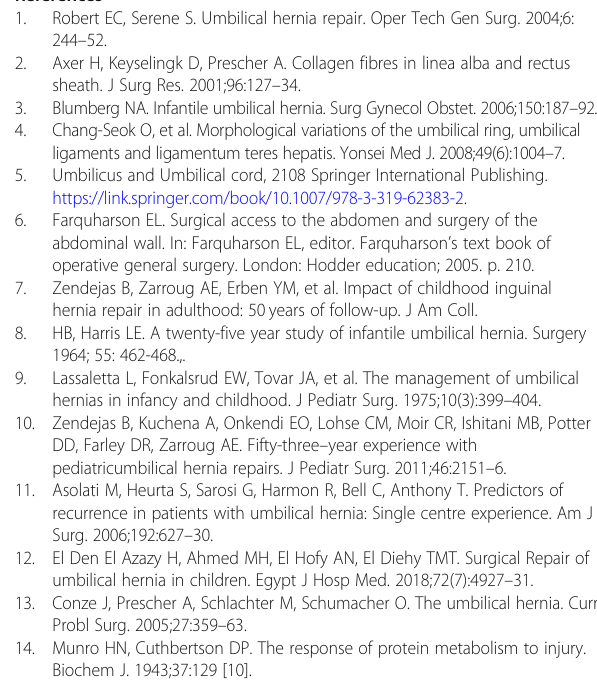
Table 2 Comparison between the four borders of the ring of the indirect umbilical hernia as regard the predominance of the transverse collagen fibres (number of cases) Borders Transverse collagen fibres Upper 11 (36%) Lower 8